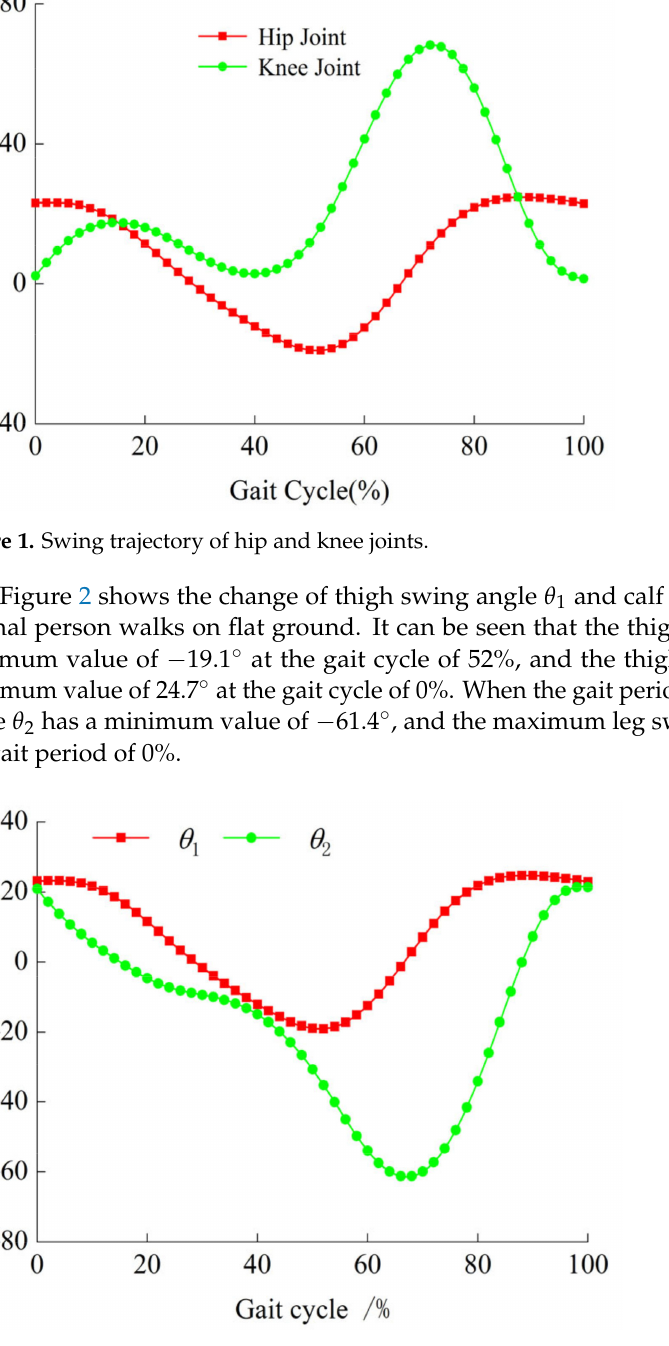
Figure 2. Swing angle of thigh angle θ 1 and calf angle θ 2